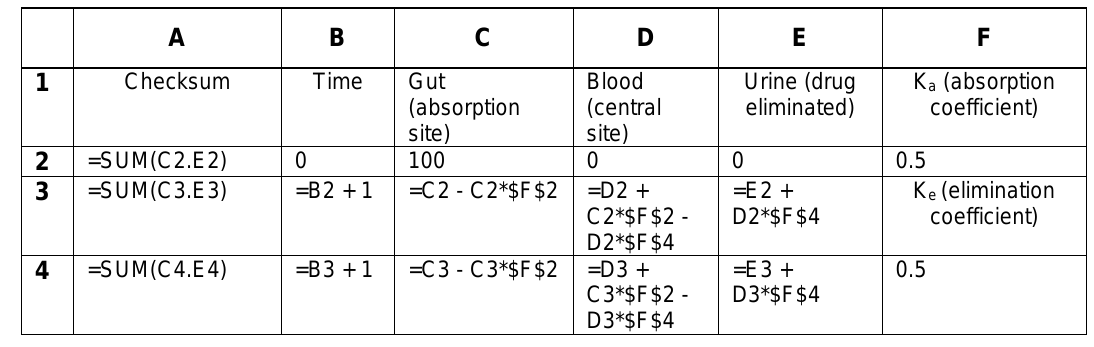
Spreadsheet Formulae for Simulation of Absorption and Elimination, Both with First-Order